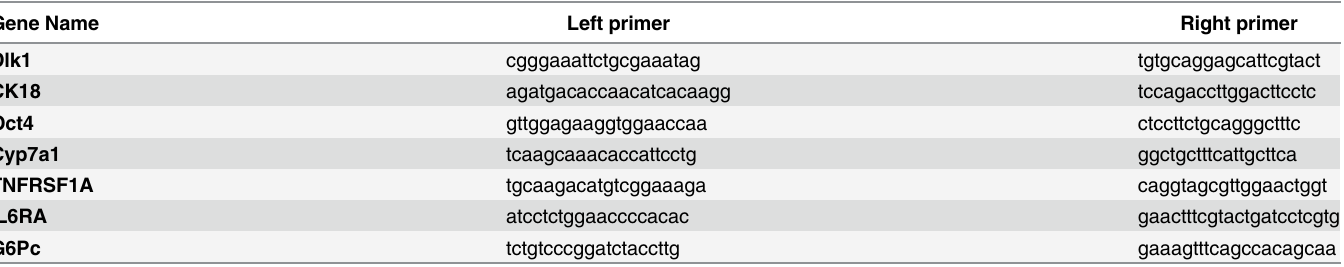
Table 1. Primers used for qRT-PCR in this study were designed using the Roche UPL library. Gene Name Left primer Right